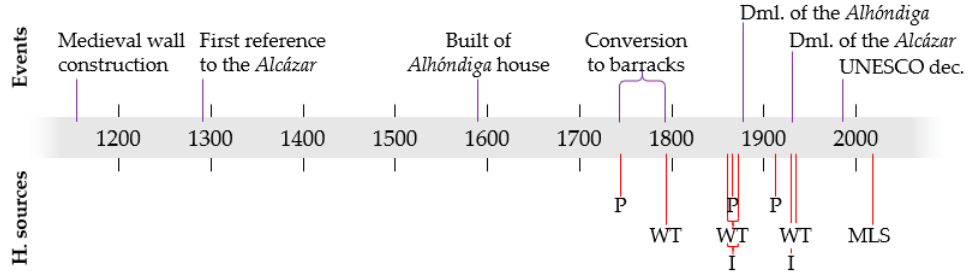
Figure 1. Chronology of Alc á zar gate evolution and historical sources employed. Abbreviations: P: plan; WT: written testimony; I: old image; MLS: mobile laser system scan; Dml: demolition.